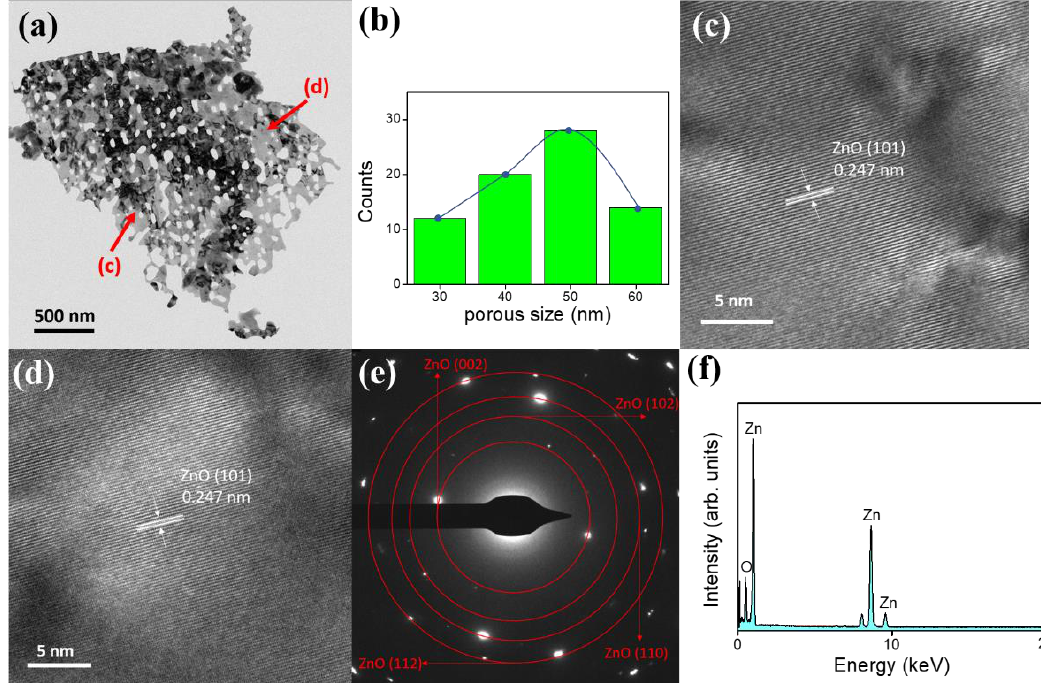
Figure 3. TEM analysis of the ZnO-A sheet: ( a ) low-magnification image. ( b ) Histogram of pore size. ( c , d ) HRTEM images. ( e ) SAED pattern. ( f ) EDS spectrum.